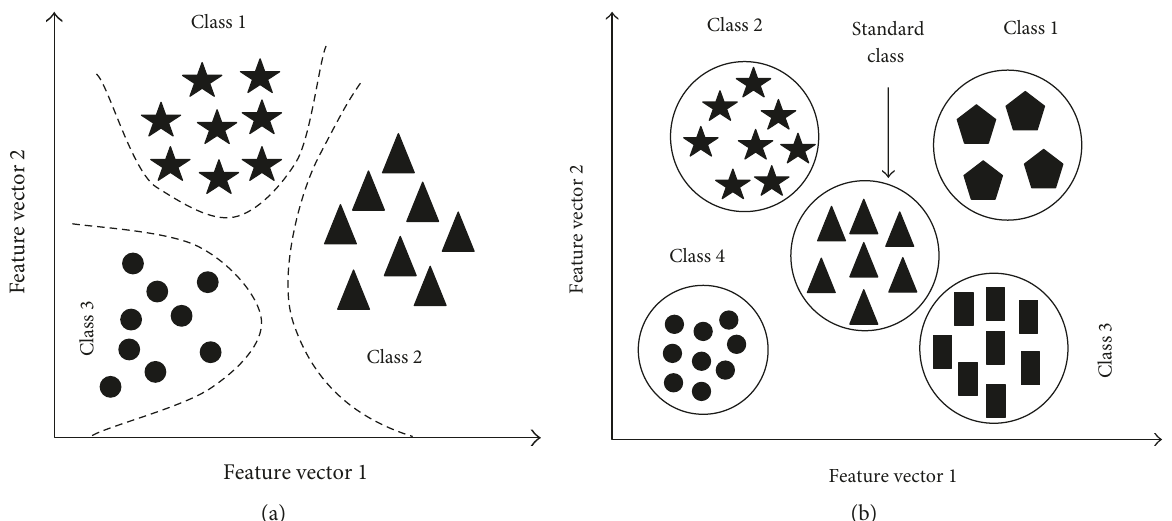
Figure 2: Architecture of k -NN classi fi er (a) simple classi fi cation and (b) cluster classi fi